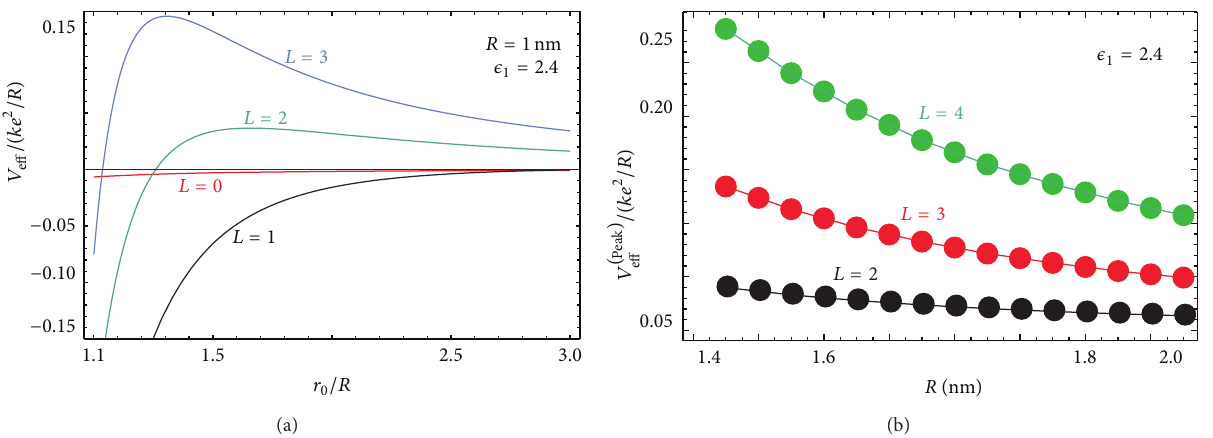
Figure 2: (a) The effective potential 𝑉 between a charged particle and a spherical shell is shown for a number of angular momenta 𝐿 . The eff radius of the sphere is 𝑅 = 1 nm and we chose 𝜖 1 = 2.4 , 𝜖 2 = 1 . In (b), the height of the peak in the effective potential appearing in (a) is plotted as a function of the radius.